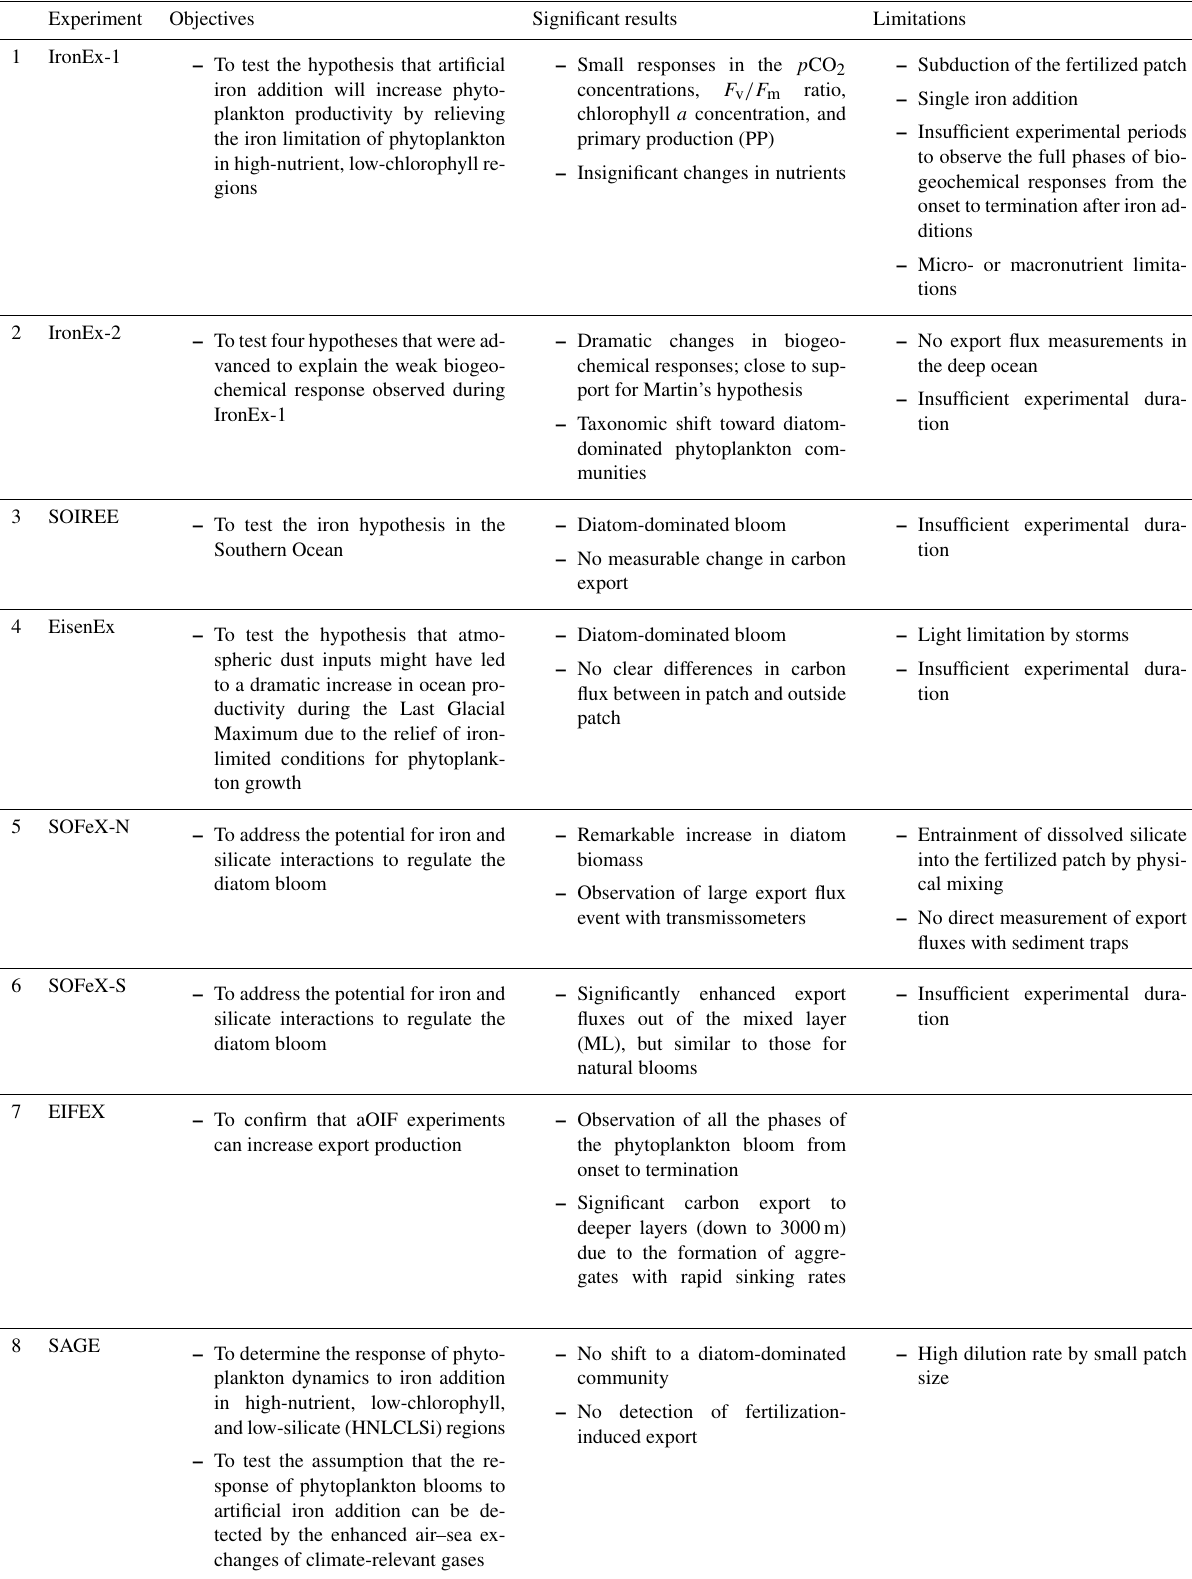
Table 2. Summary of artificial ocean iron fertilization (aOIF) experiments: objectives, significant results, and limitations.